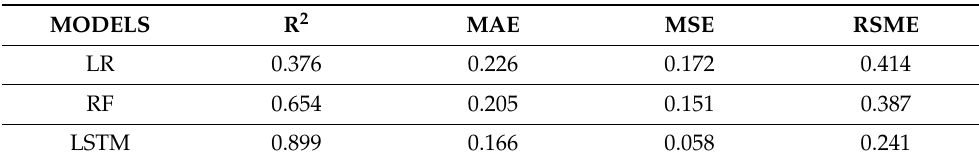
Table 2. Comparison of the performance metrics of the proposed model with linear regression and random forest models.